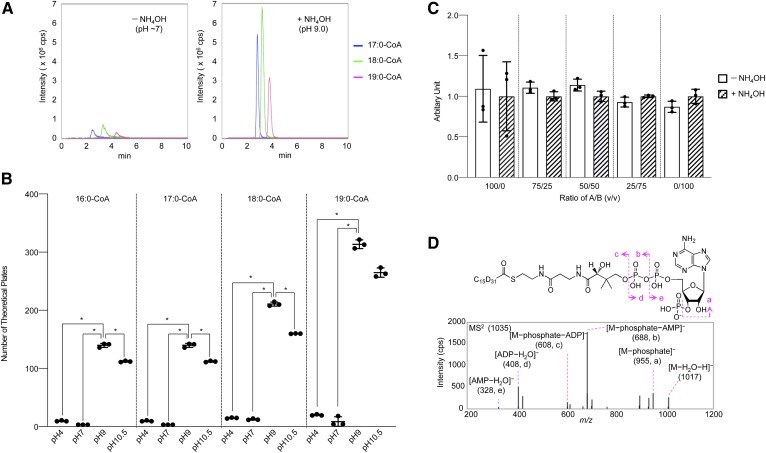
Development of an LC-MS method for acyl-CoA analysis. A: The effect of the mobile phase pH on the separation and sensitivity of each acyl-CoA species. A mixture containing 50 pmol of 17:0-, 18.0-, or 19.0-CoA was analyzed by LC-MS using mobile phases adjusted to either ∼pH 7 or pH 9.0 with ammonium hydroxide. B: The effect of mobile phase pH on separation performance for acyl-CoA analysis. The number of theoretical plates for all four acyl-CoA species (16:0-, 17:0-, 18:0-, and 19:0-CoA) was highest when the mobile phases were adjusted to pH 9.0. C: The stability of acyl-CoA under alkaline conditions. A solution of 17:0-CoA was preincubated for 1 h with mobile phases adjusted to (pH 9.0) or without ammonium hydroxide (∼pH 7) and analyzed by LC-MS using mobile phases adjusted to pH 9.0. No significant difference was observed in the sensitivity of 17:0-CoA detection in the pretreated samples irrespective of the ratio of mobile phase A (water) to B (isopropanol) used during preincubation. Data represent the mean ± SD, n = 3. D: The MS/MS (MS2) spectra of chemically synthesized D31-16:0-CoA corresponding to m/z = 1,035 ([M−H]–). Spectra for both hydrophobic ([M−phosphate]–, [M−phosphate−adenosine monophosphate]–, and [adenosine diphosphate-water]– and [adenosine diphosphate−water]–) were observed. Statistical analysis was performed with one-way ANOVA followed by the Tukey post hoc test in B and the Student’s t-test in C. *P < 0.05 for comparisons between pH 4.0, pH 6.5, pH 9.0, and pH 10.5 (B) or between −NH4OH and +NH4OH (C).